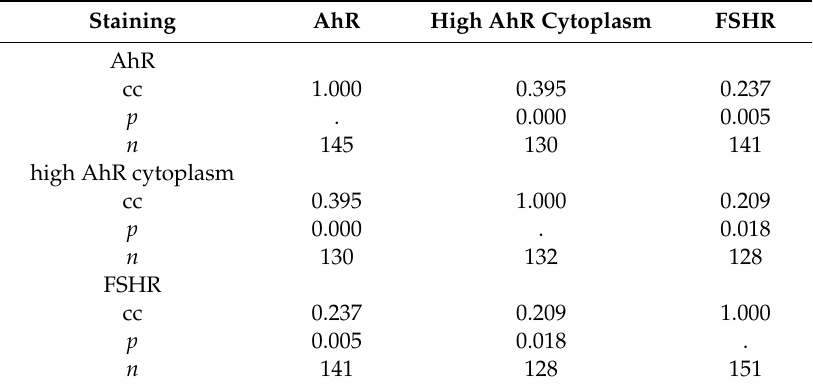
Table 2. Correlation analysis for AhR, high AhR in the cytoplasm, and FSHR.